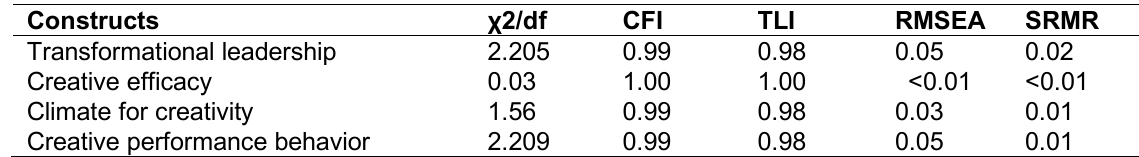
Table 4 : CFA for the measurement model